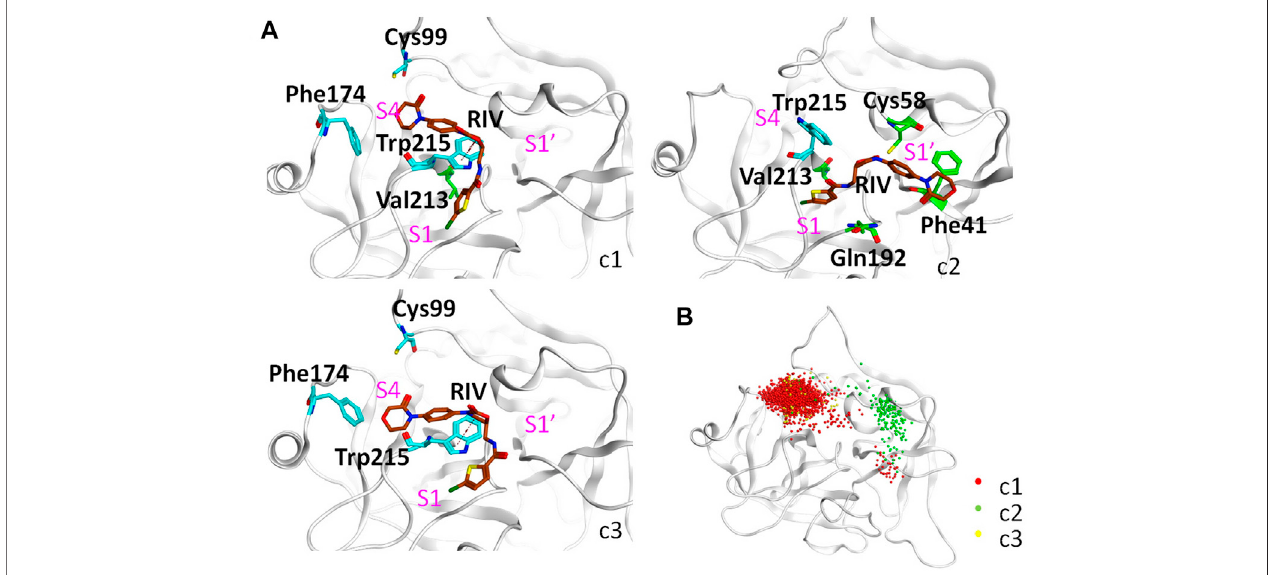
FIGURE5| DetailedanalysisonthebindingofRIVintheY99Cmutant. (A) Representativebindingmodesofthetopthreeclusters.RIVcarbonatomsarecoloredin brown, the S4 pocket residues are shown in cyan, other residues important to RIV binding are shown in green, and the positions of the three pockets are labeled in magenta. (B) Distributions of the R4 group are visualized by the positions of the C3 atom of RIV.